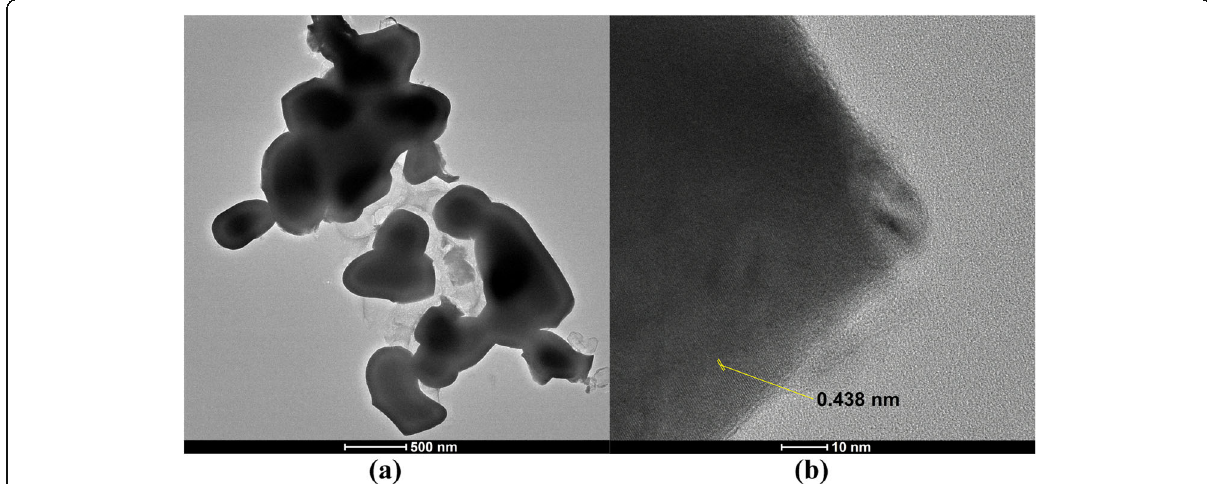
Fig. 10 a TEM and b HRTEM images of pure m-Li 2 ZrO 3 powders prepared by solid-state